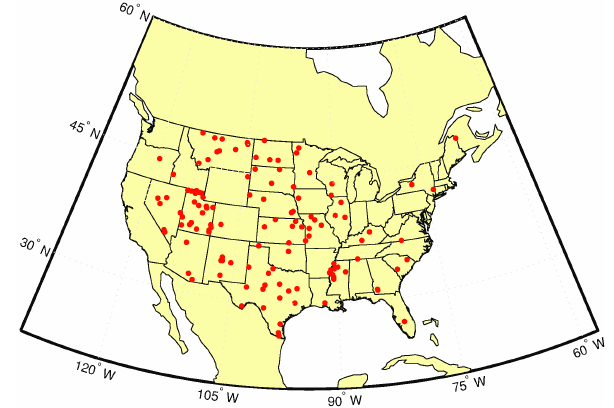
Figure 4. Locations of the in situ measurement sites used in this study.